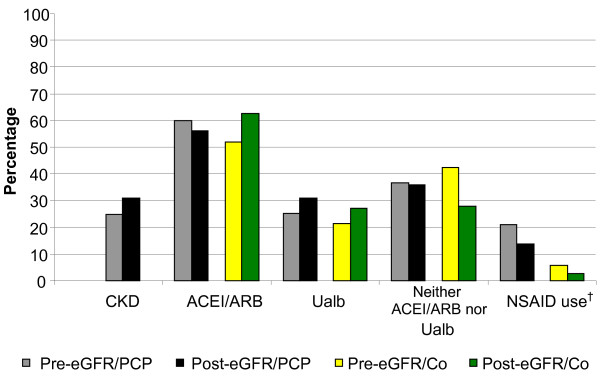
Quality of care delivered to CKD 3b-4 patients.Pre-eGFR cohort: n=274, Post-eGFR cohort: n=266.† Pre-eGFR/PCP vs. Post-eGFR/PCP, P=0.07; Pre-eGFR/PCP vs. Pre-eGFR/Co, P=0.01; PosteGFR/  PCP vs. Post-eGFR/Co, P=0.003.CKD chronic kidney disease documentation, ACEI/ARB angiotensin converting enzyme  inhibitor or angiotensin receptor blocker use, NSAID non-steroidal anti-inflammatory drug, Ualb  quantitative urinary albumin testing, eGFR estimated glomerular filtration rate, PCP primary  care physician managed, Co co-managed.